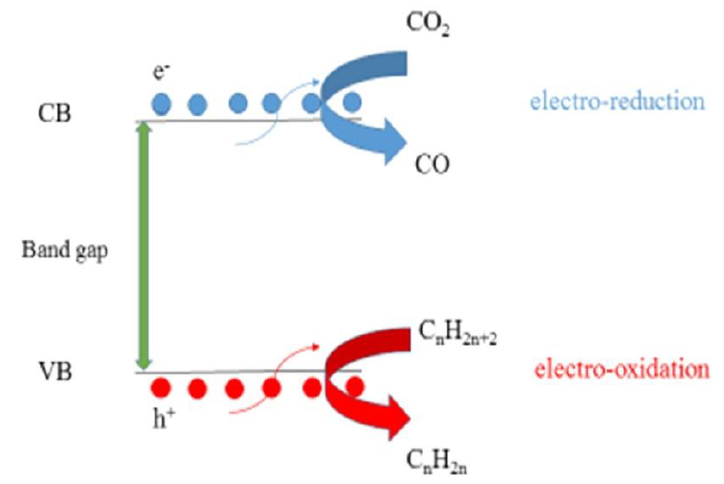
Figure 16. Proposed mechanism for oxidative dehydrogenation of LPG under external electric field.